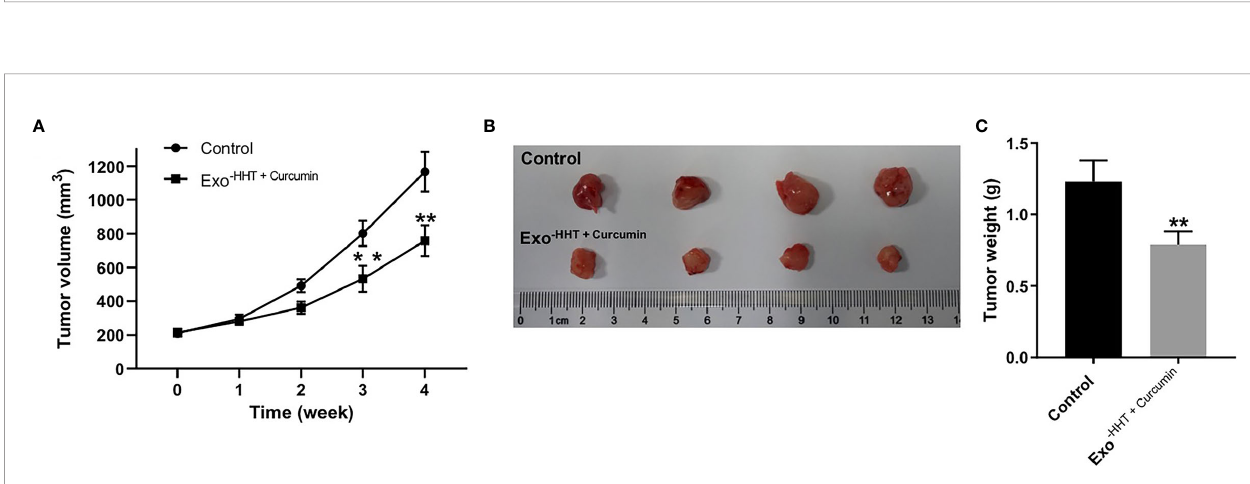
FIGURE 7 | Raji/combination exosomes inhibited tumorigenesis in Raji xenograft in vivo . (A) Tumor volume was calculated. (B) Raji xenograft tumors were photographed, and (C) the tumor tissues were weighed. **P < 0.01 compared with control group.